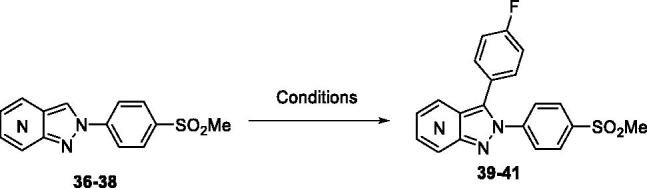
Synthesis of fluorinated azaindazoles. Reagents and conditions: 4-Iodofluorobenzene(1.1 equiv), Ag2CO3 (1.0 equiv), Pd(dppf)Cl2.CH2Cl2 (0.05 equiv), PPh3 (0.10 equiv), H2O, 50 °C, 18 h, 39: 4-aza 63%; 40: 6-aza 75%; 41: 7-aza 79%.